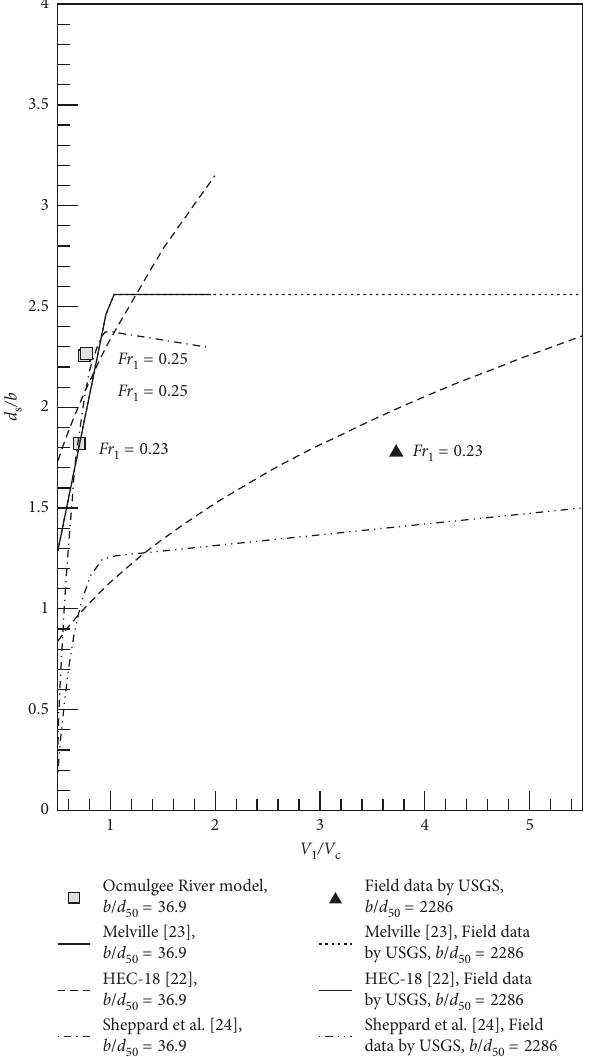
Figure 10: Comparison of field and laboratory measurements of scour depths and scour prediction formulas for Ocmulgee River